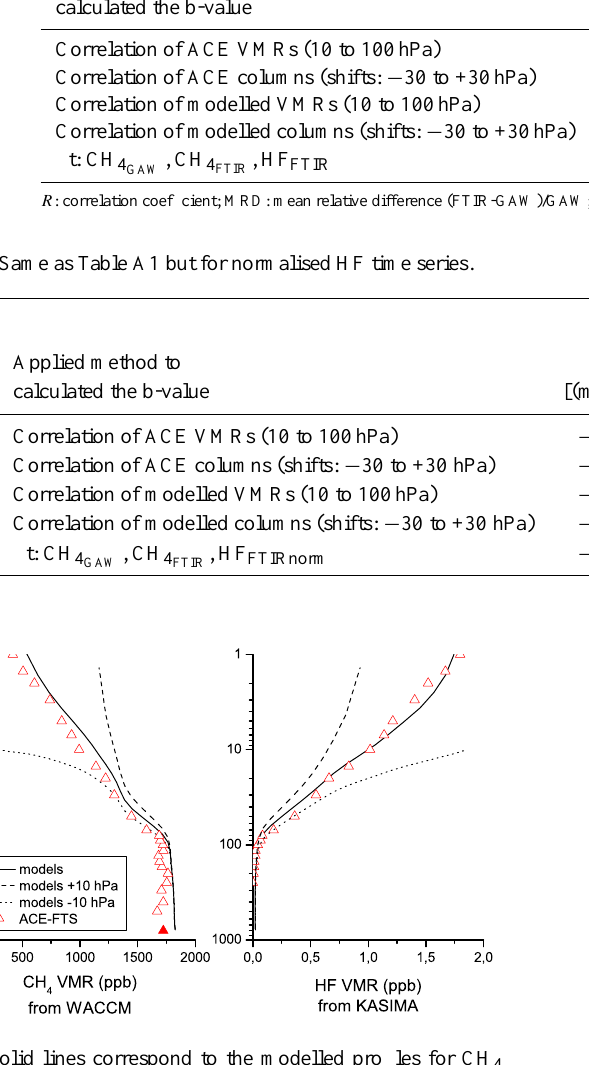
Table A1. troCH 4